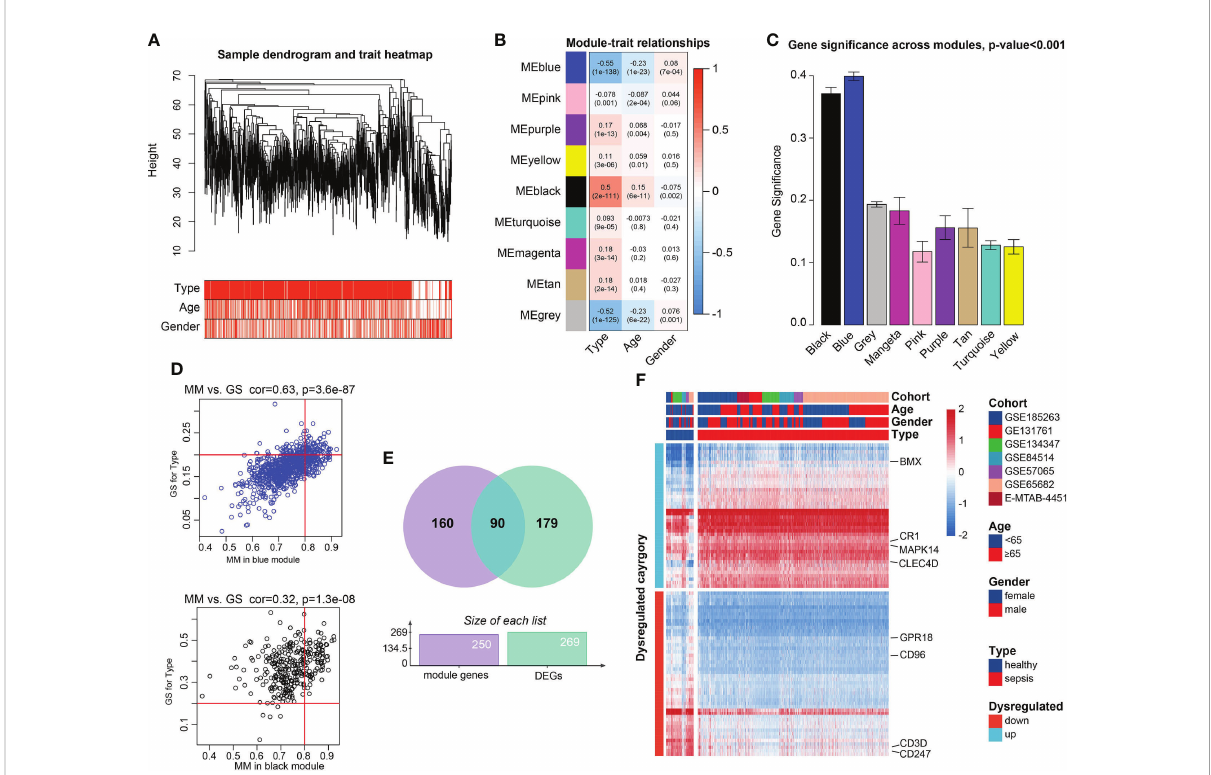
FIGURE 2 Candidate genes detection. (A) Clustering dendrogram of the saved 1,778 sepsis samples in WGCNA and clinical features. (B) Heatmap of Pearson correlation analysis of modules and clinical traits. Rows represent modules and columns represent traits. The values in the squares represent correlation degree and p values. Color red represents positive correlation and color blue represents negative correlation. (C) Boxplots of GS among 9 modules. Module blue and module black demonstrated higher values gene signi fi cance, than that of the 7 modules, tested by t- test. (D) Scatter plots of Correlation of GS within MM. Genes with |GS |>0.2 and |MM |>0.8 were considered signi fi cant. (E) Venn plot of the intersections between DEGs and genes fi ltered from WGCNA. (F) Heatmap of the candidate genes. The expression values were normalized from -2 to 2. Color red represents relatively increased expression and color blue represents relatively deceased